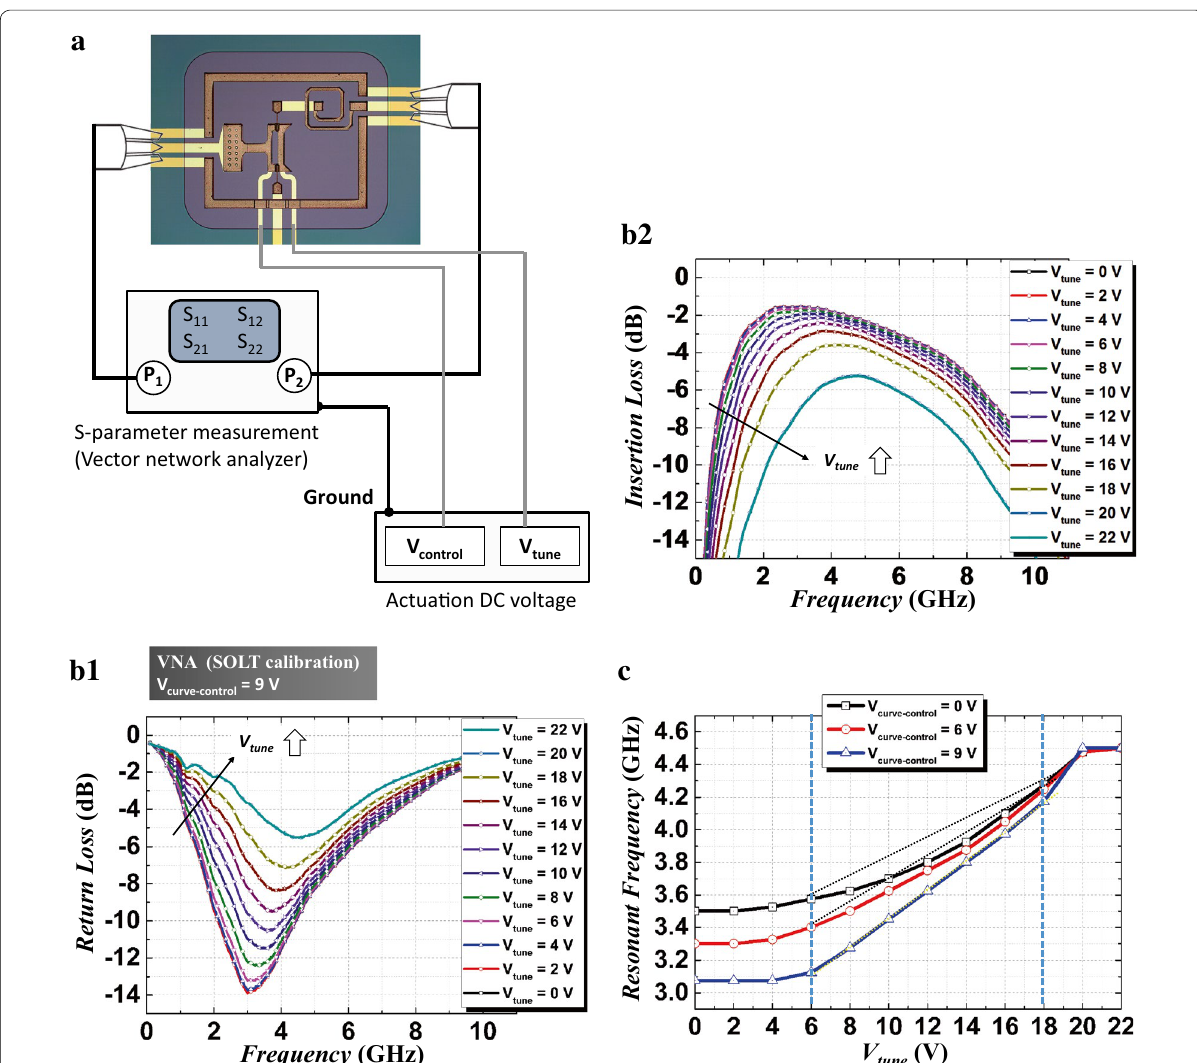
Fig. 7 Measured results. a Measurement setup. b Return loss and insertion loss with respect to frequency sweep. c Resonant frequency of the fabricated series LC resonator according to